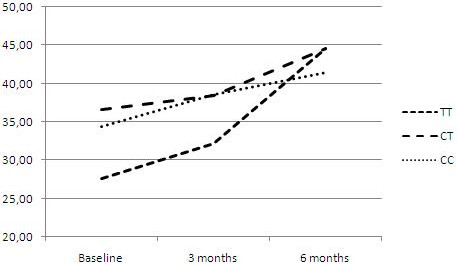
Representation of changes in US score according to TGF-β 869C/T genotype after three and six months of anti-TNF therapy.